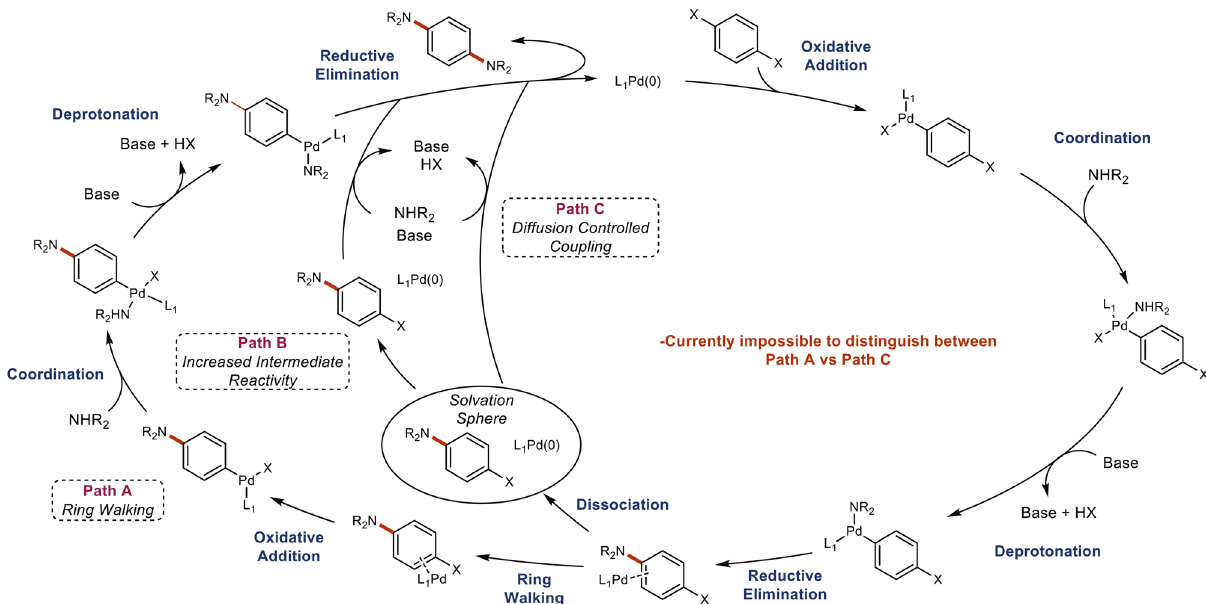
Fig. 2 Prototypical Buchwald-Hartwig amination mechanism. Prototypical Buchwald-Hartwig amination with ring walking in which the catalyst remains bound to the pi system throughout the cycle (path A), increased intermediate reactivity, which can often be mistaken for ring walking (path B), and diffusion-controlled coupling in which the catalyst remains within the solvation sphere of the intermediate and begins a second round of coupling (path C). Prior to this work, it was impossible to distinguish between paths A and